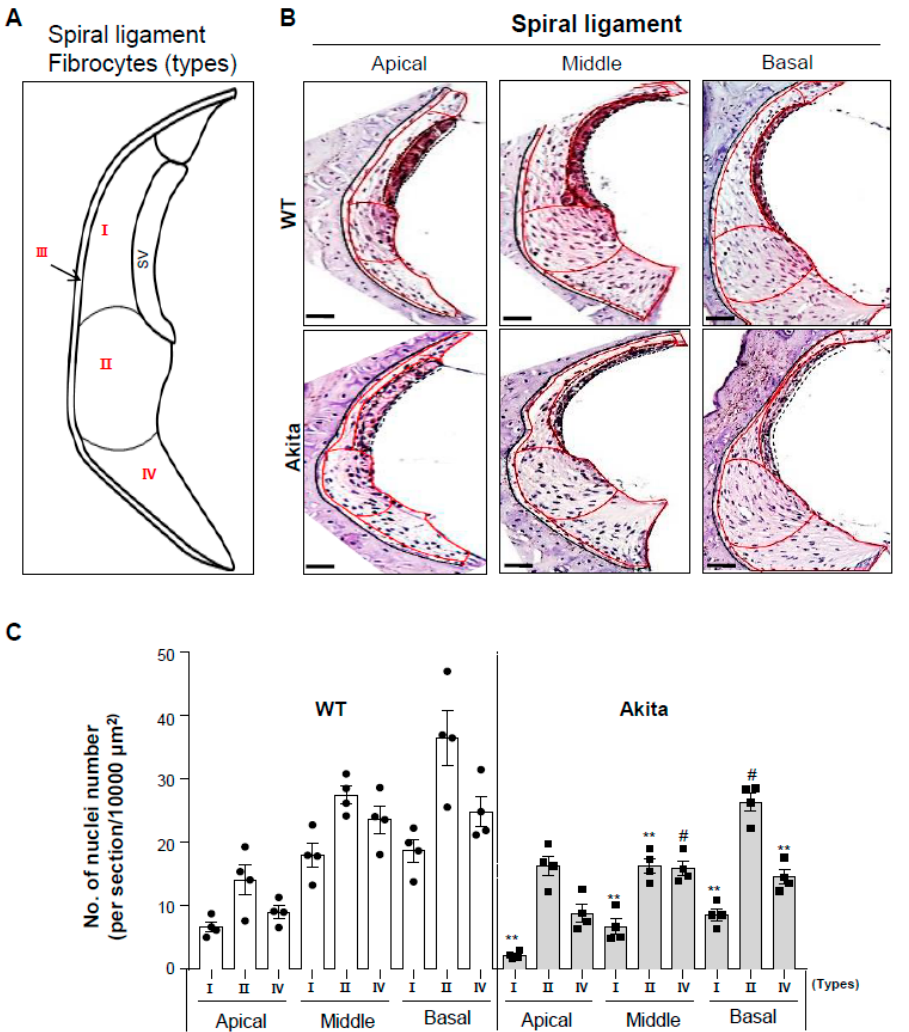
Figure 4. Comparative study of the spiral ligament (SL) in cochleae of WT and Akita mice. ( A ) Diagram of various types (I–IV) of fibrocytes in the lateral wall (LW) structures. ( B ) H&E staining of WT (upper) and Akita mice (lower) showing the four types of SL separated by a red line. Scale bar, 50 µ m. ( C ) The Akita mice had an abnormal morphology with a loss of nuclei in types I, II, and IV. The graph shows the quantification of hematoxylin-stained nuclei in SL type I, II, and IV fibrocytes in the apical, middle, and basal turns of Akita mice compared to WT. Individual circles represent individual mice ( n = 4 for each group). Scale bar, 50 µ m. Results are means ± SEM. # p < 0.05, ** p < 0.01 by one-way ANOVA followed by Tukey’s HSD post hoc test.